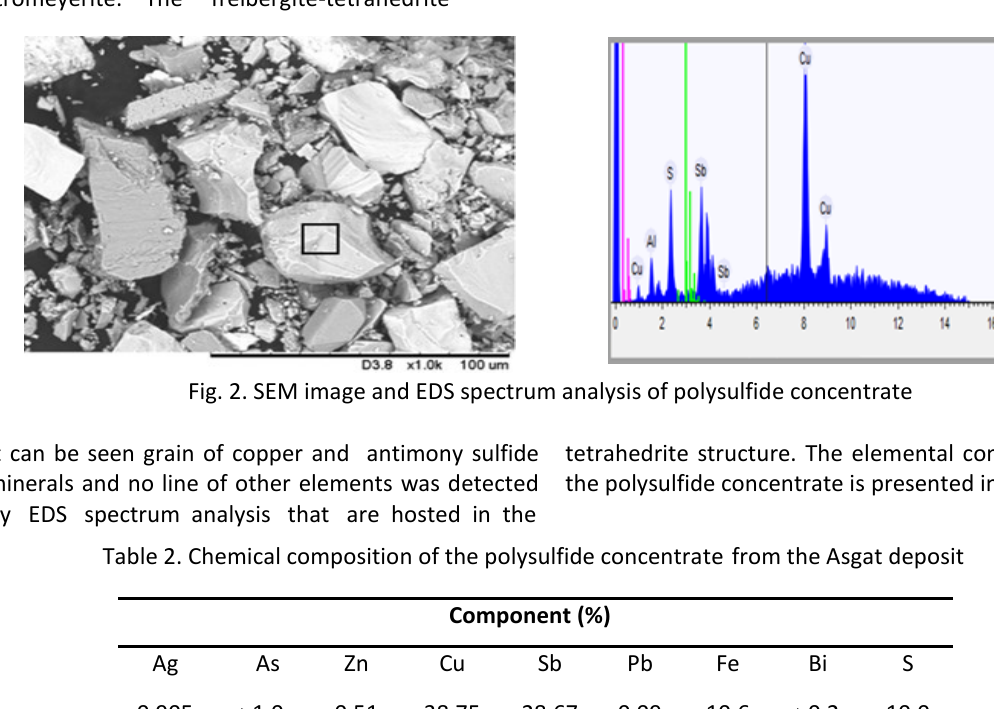
Fig. 4. Effect sulfuric acid concentration on metals (Sb, Ag, Cu, Fe) dissolution